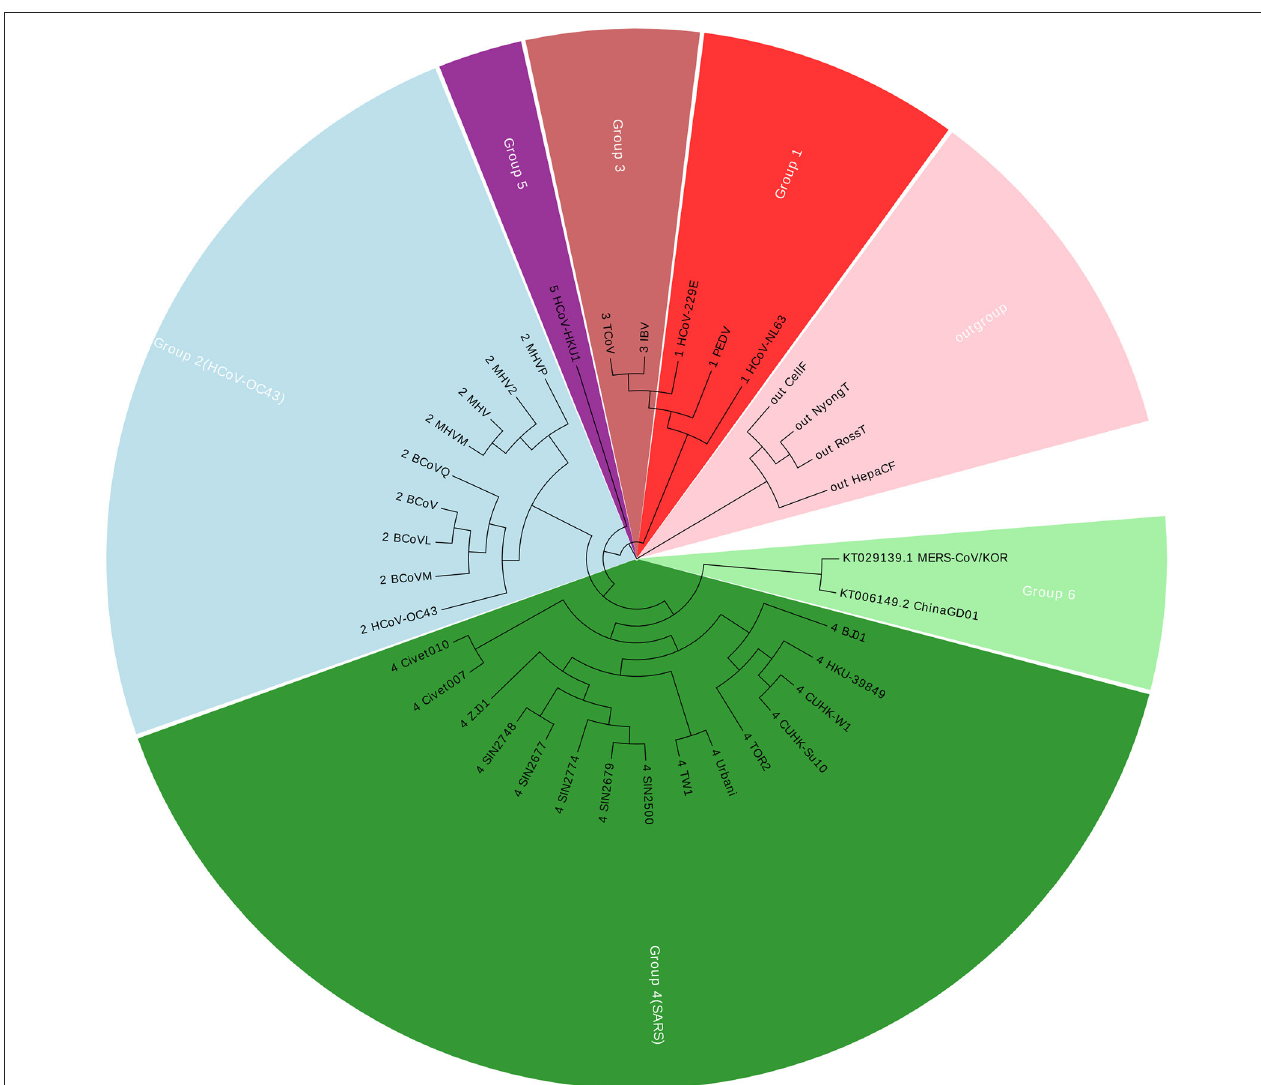
FIGURE 1 | The phylogenetic UPGMA tree using ANV method on Coronaviruses dataset.